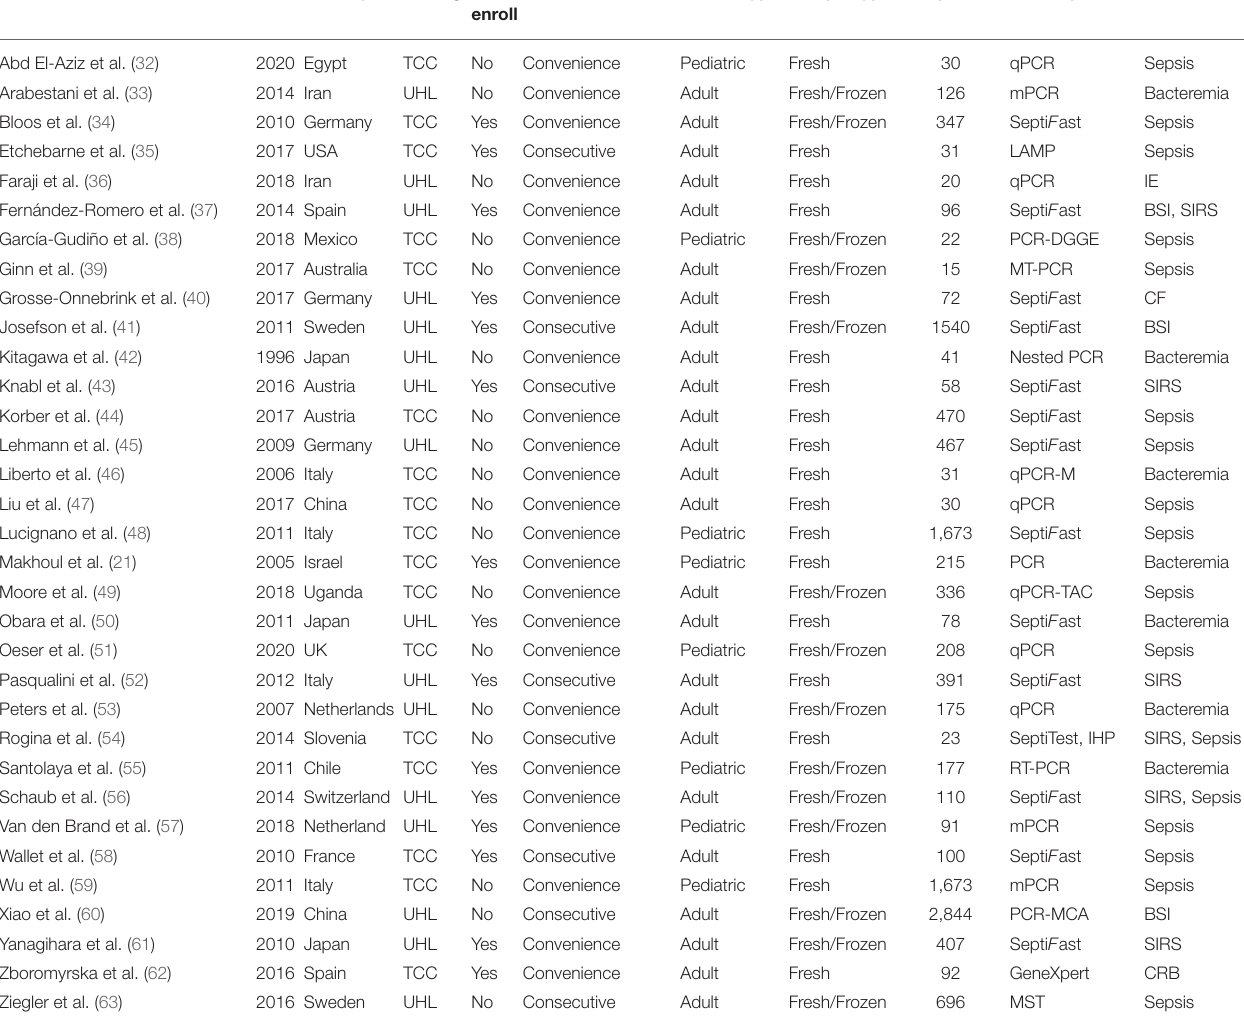
TABLE 1 | Baseline features of included